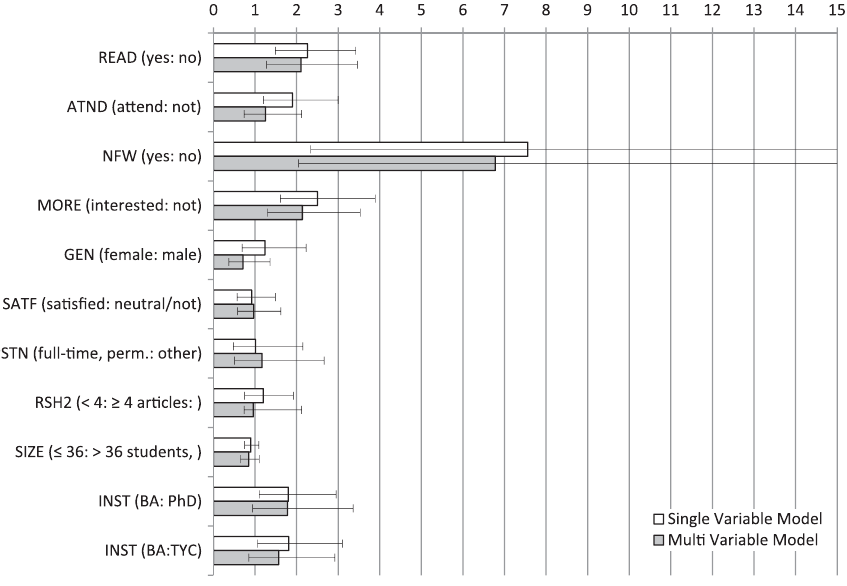
FIG. 3. Odds ratios and 95% confidence intervals for tried versus not-tried groups. The 95% confidence intervals for the NFW variable extend off the chart. A confidence interval that includes ‘‘1’’ suggests that the groups are not significantly